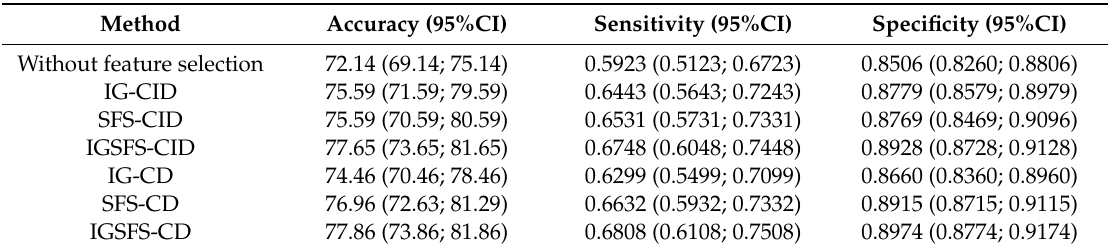
Table 12. Estimate of accuracy, sensitivity, and specificity of performance measures for